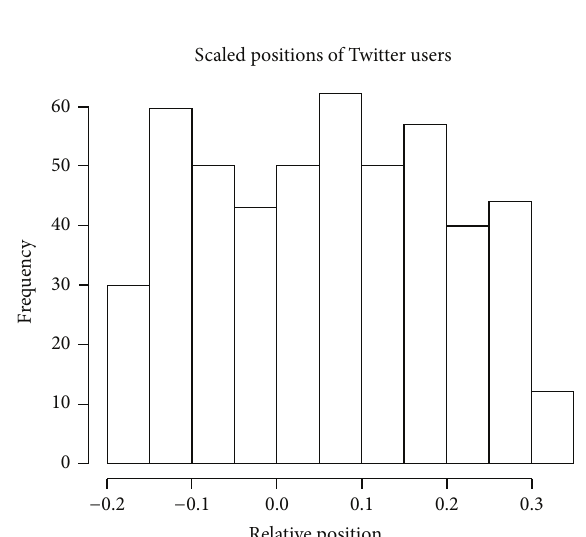
Figure 2: Term frequency of the corpus.